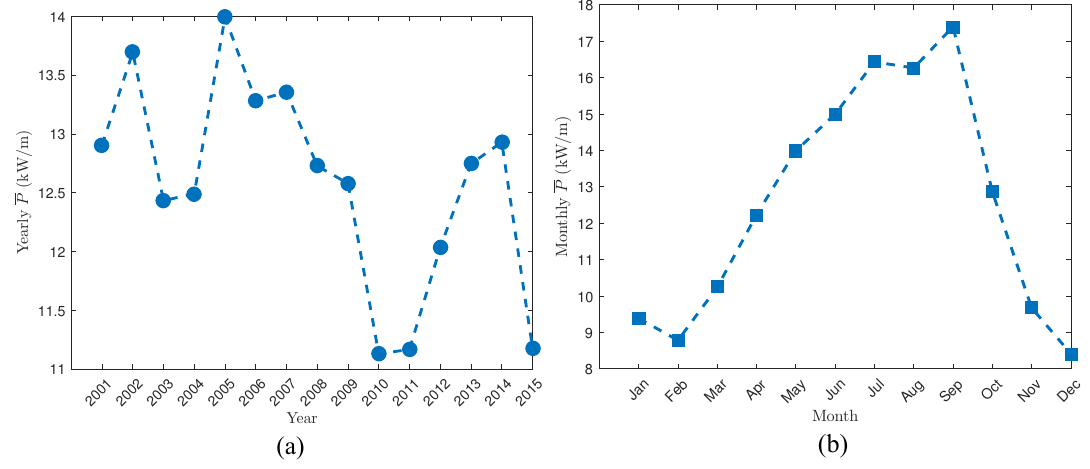
(a) Figure 5. Yearly ( a ) and monthly ( b ) mean wave power